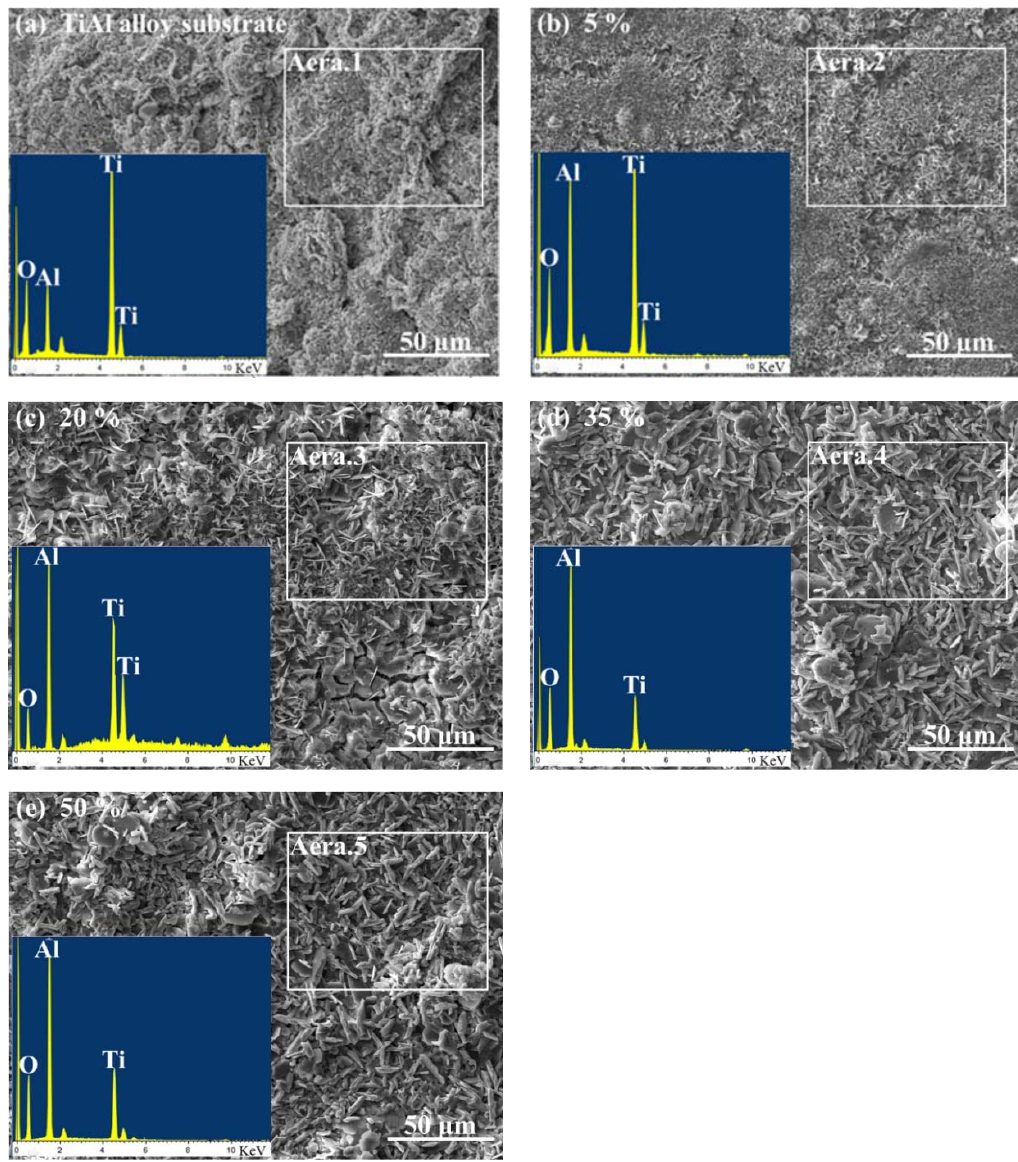
Figure 10. Surface morphology and EDS analysis of TiAl alloy and CPED coatings after an intermittent isothermal oxidation test.